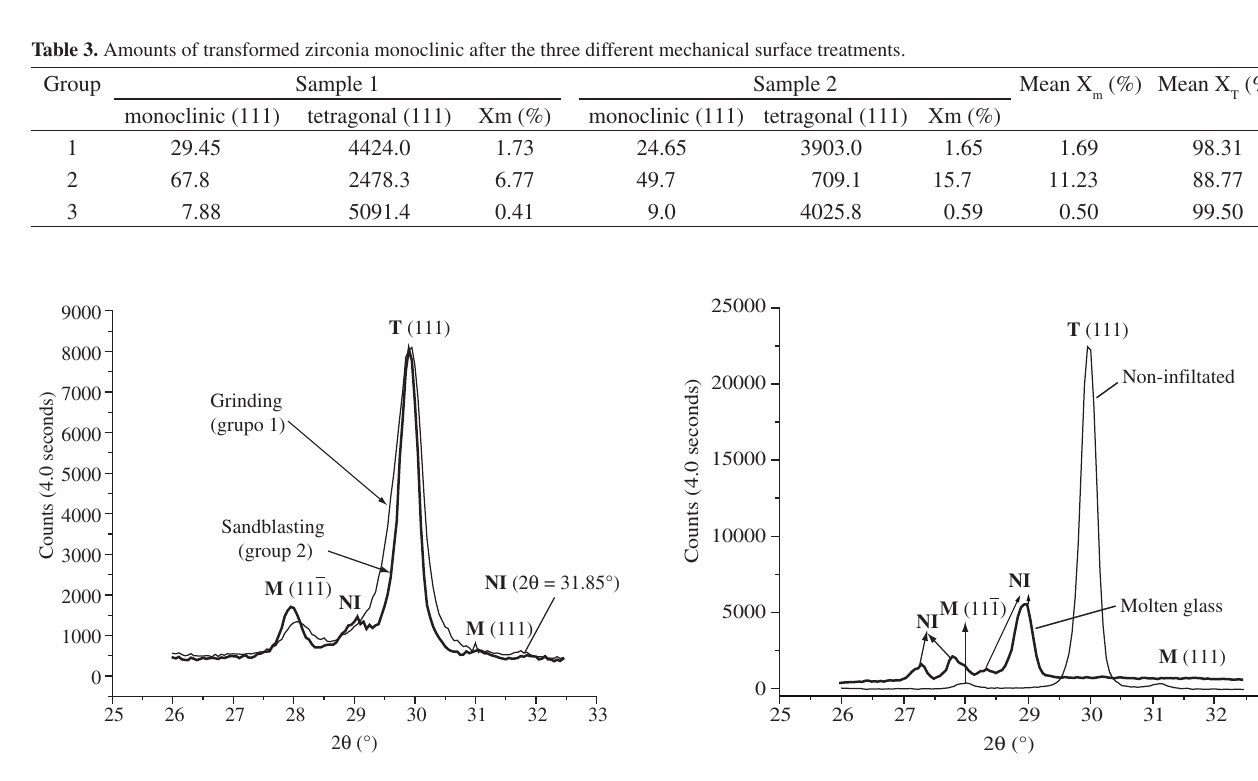
Figure 4. X ray diffraction of infiltrated ZTA disks after two different me- chanical surface treatments: Grinding (group 1) and sandblasting (group 2). It can be seen an enlargement of the tetragonal base peak (111) of grinded sample indicating some disruption of the lattice parameters due to the grinding treatment. NI = non-identified peak.